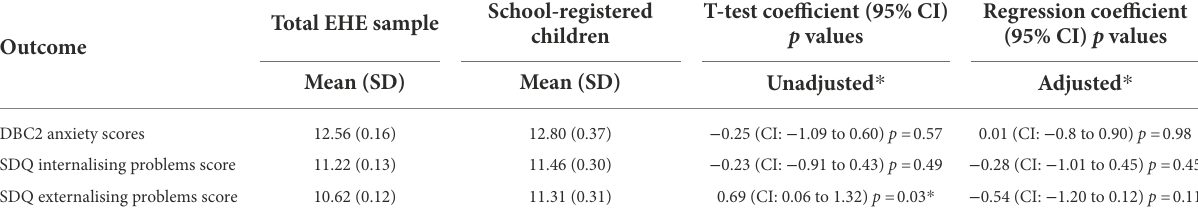
CI = confidence intervals; * = significant results; unadjusted * = t -tests; adjusted * = linear regression adjusted for child’s age, child’s gender, child’s ethnicity, child living in England, child having additional physical conditions, child having two or more neurodevelopmental conditions, child having intellectual disability, child having formal recognition of special educational needs and family socioeconomic deprivation and parent